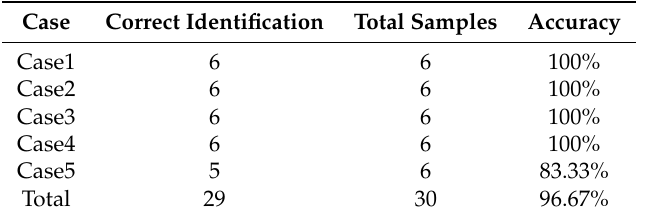
Table 5. Five experiments of proportional blending in the